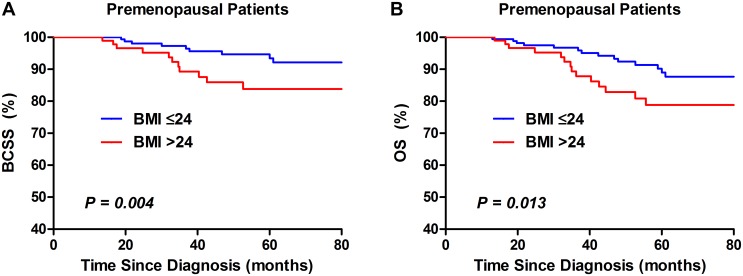
Kaplan–Meier curves of BCSS (A) and OS (B) by BMI groups in premenopausal TNBC patients.